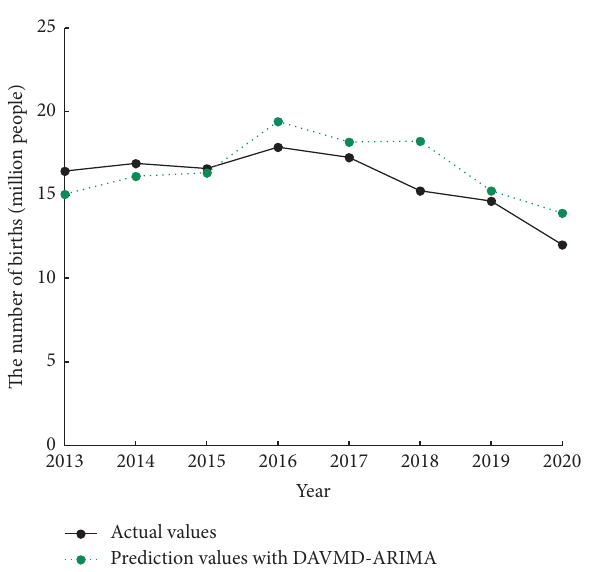
Figure 2: The actual China’s birth population and the prediction results for China’s birth population with